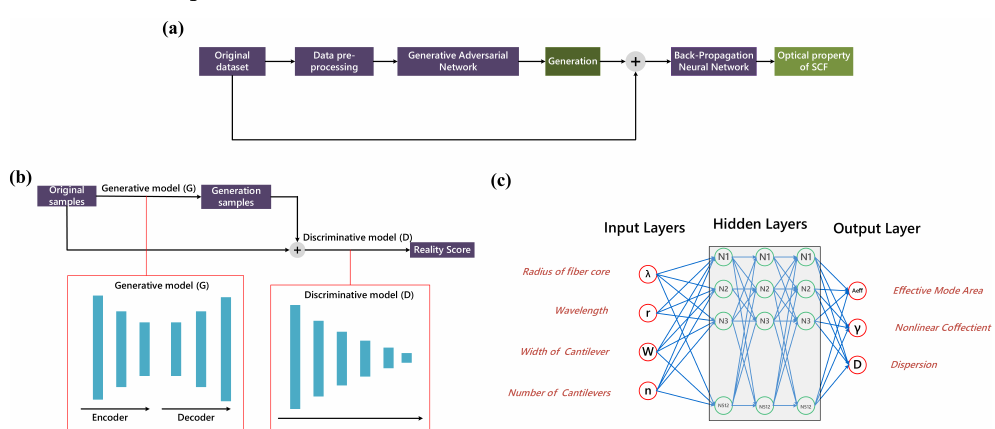
Figure 2. ( a ) Computational flow of the proposed model. ( b ) Processing flow and structure diagram of a generative adversarial network for data augmentation, G is a typical encoder-decoder structure with 512, 256, 128, 128, 256, 512 neurons per layer (full-connection layer, from left to right), and D with 512, 256, 128, 64, 32, 1 neuron per layer (full-connection layer, from left to the right). ( c ) The structure of the back-propagation neural network for optical properties calculation has three hidden layers with 512 neurons each, one input layer and one output layer, the input layer corresponds to the four geometric features of the SCF, and the output layer corresponds to the optical properties to be